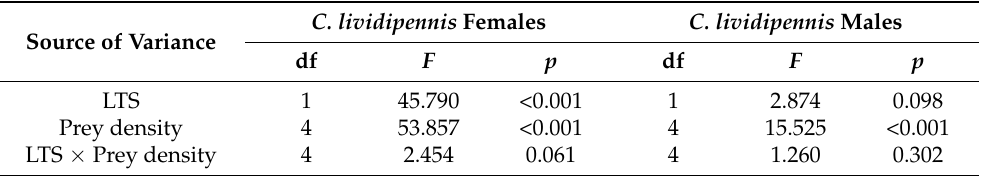
Table 1. Results of general linear models (GLM) analyzing the effects of low temperature storage